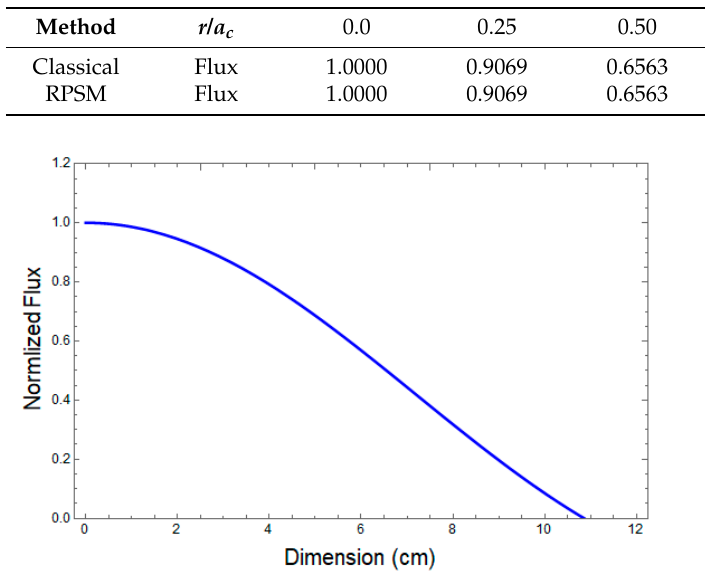
Table 3. Normalized flux in one-group bare reactor.